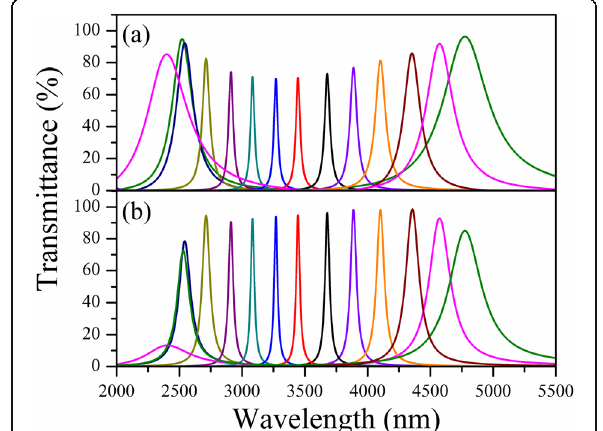
Fig. 3 Simulated transmission spectrum of Ge/SiO multi-layer structure with both functions of the out-of-band rejection in 1.6~2.5 μ m and the antireflection in 2.5~5 μ m